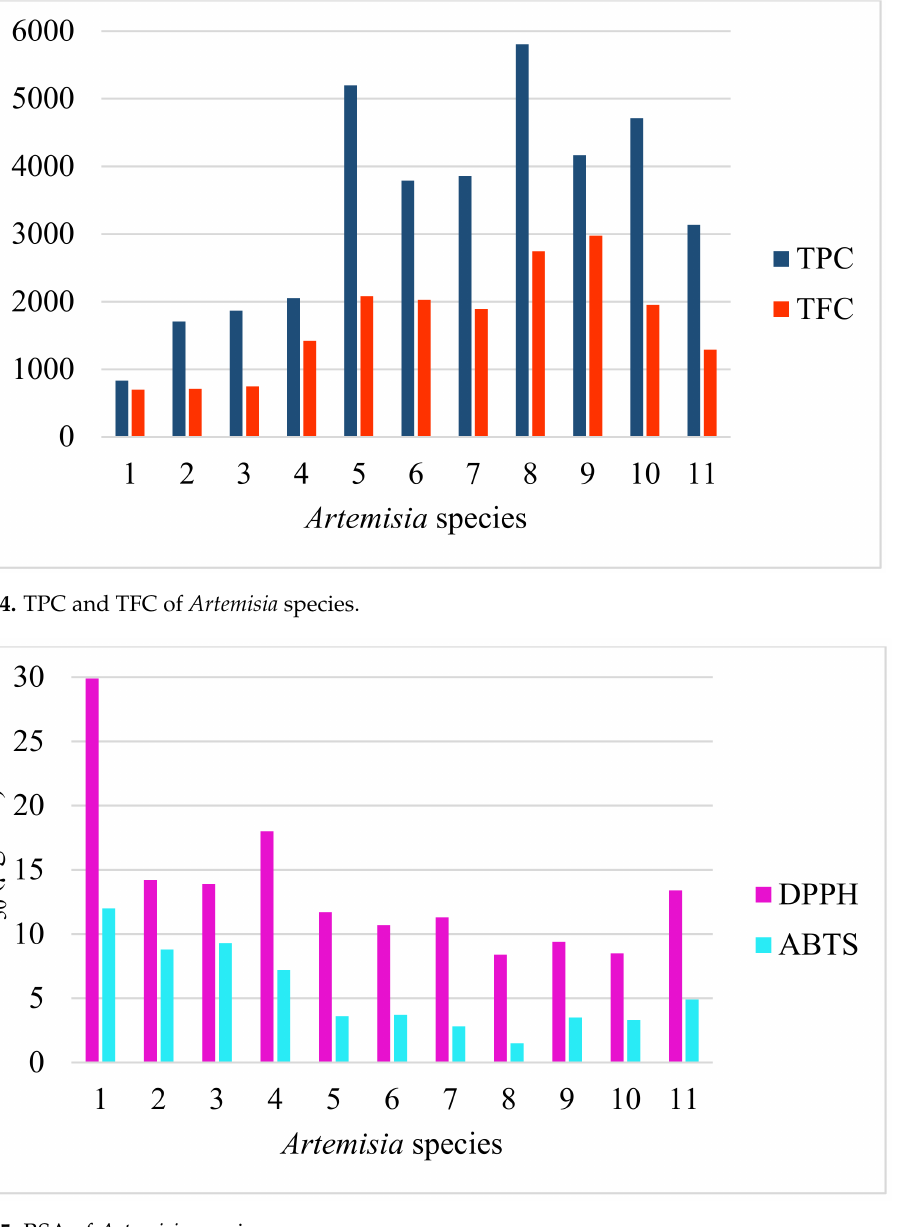
Figure 5. RSA of Artemisia